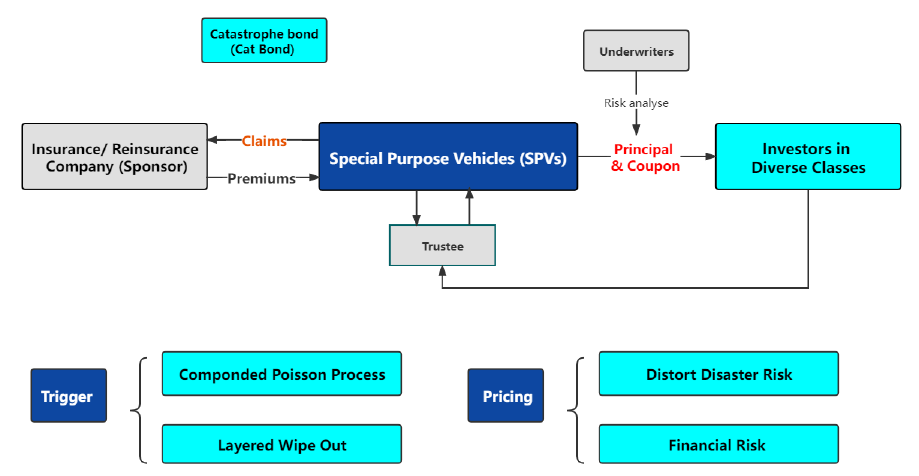
Figure 5. Operation mechanism for catastrophe